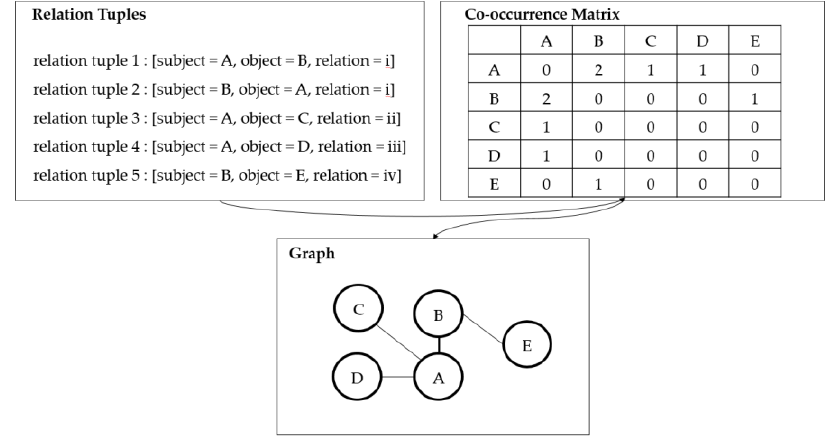
Figure 3. Schematic diagram of co-occurrence matrix construction.